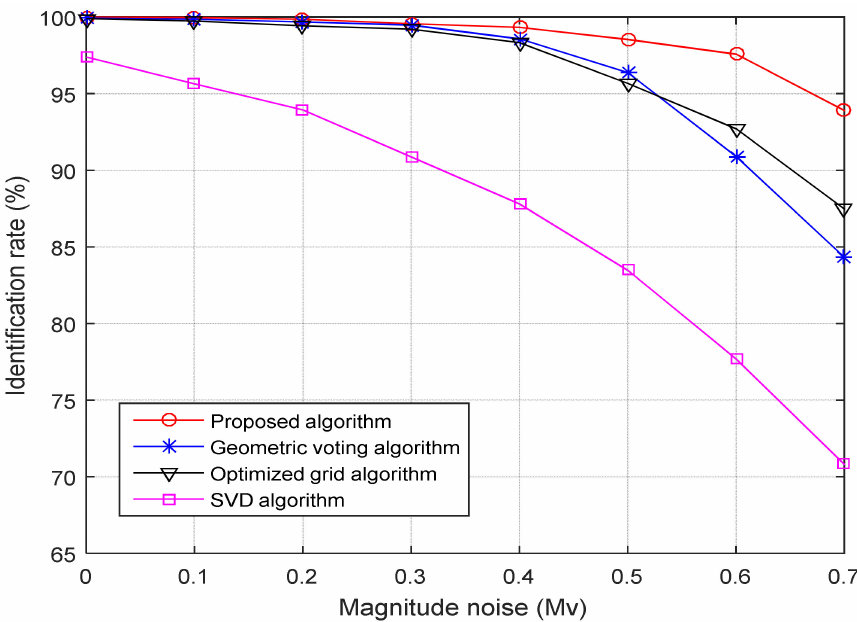
Figure 7. Identification rate versus magnitude